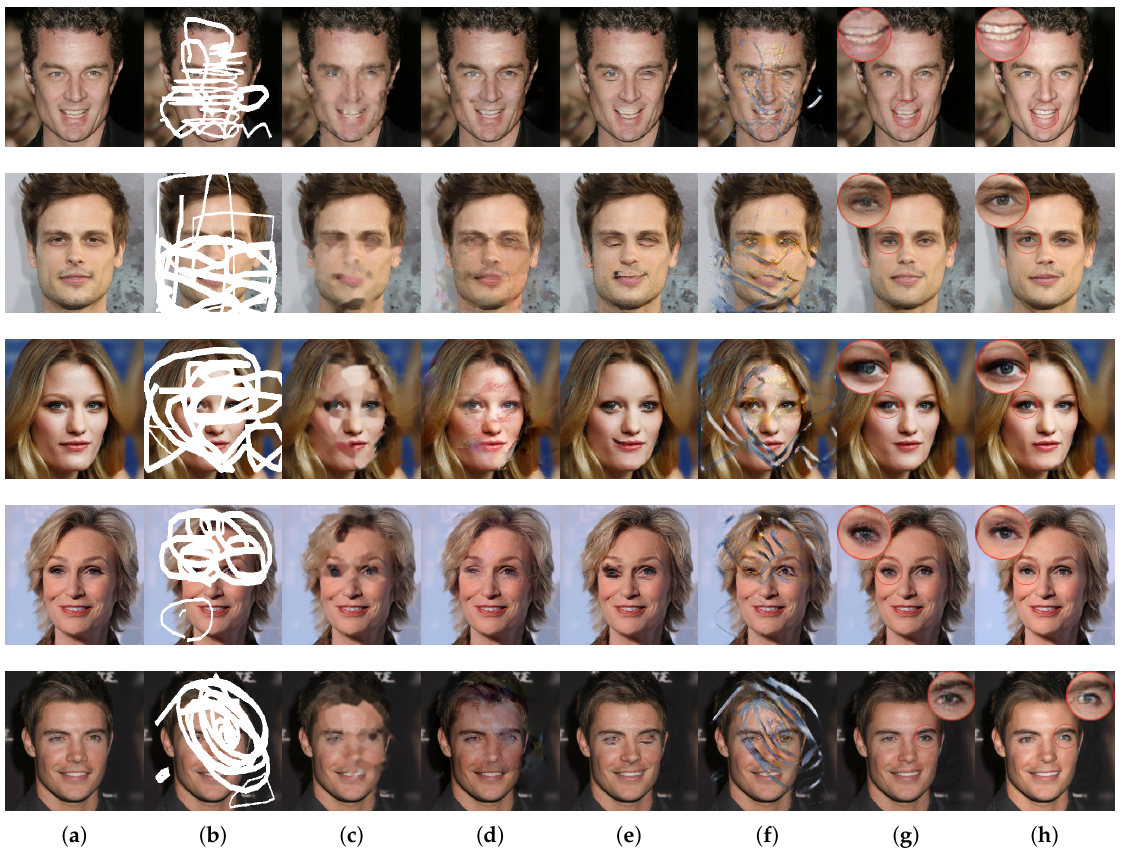
Figure 5. Comparison of qualitative results with the existing methods on irregular masked CelebA-HQ. ( a ) ground truth images; ( b ) masked input images; ( c ) results of the FMM [31]; ( d ) results of the Globally-Locally [19]; ( e ) results of the DFNet [38]; ( f ) results of the GMCNN [37]; ( g ) results of the EdgeConnect [23]; ( h ) results of the proposed method PIC-EC, best viewed with